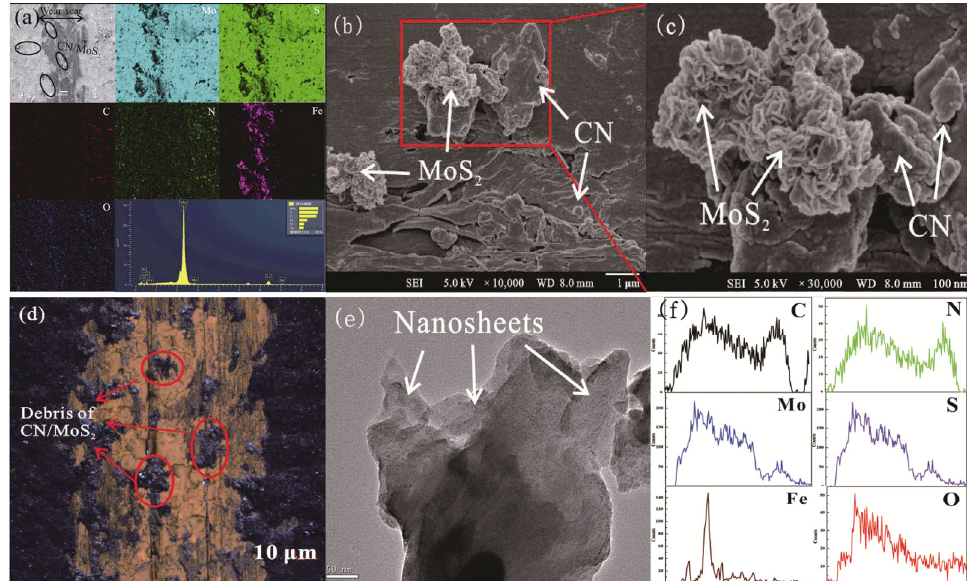
Fig. 5 (a) SEM image and EDS mapping, (b, c) SEM images, (d) optical image of wear surfaces, (e) TEM image, and (f) line scan mapping of materials at the contact